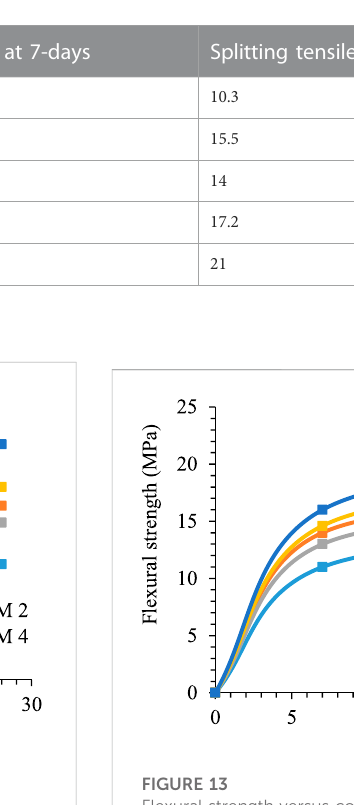
Flexural strength versus concrete age